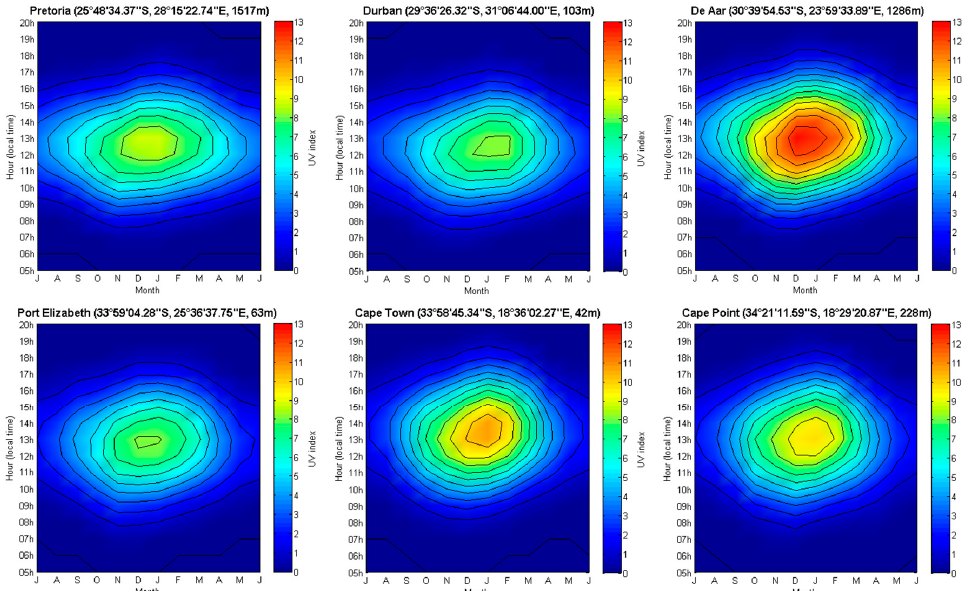
Figure 4. The monthly climatological median ground-based solar UV index levels for all six South African sites for all available years between 1994 and 2015 shown as a function of time of day and month of the year. For seasons to be shown more easily, the plots show the first month on the X -axis as July through to December, followed by January through to June. Therefore, summer months are in the middle of the plot.